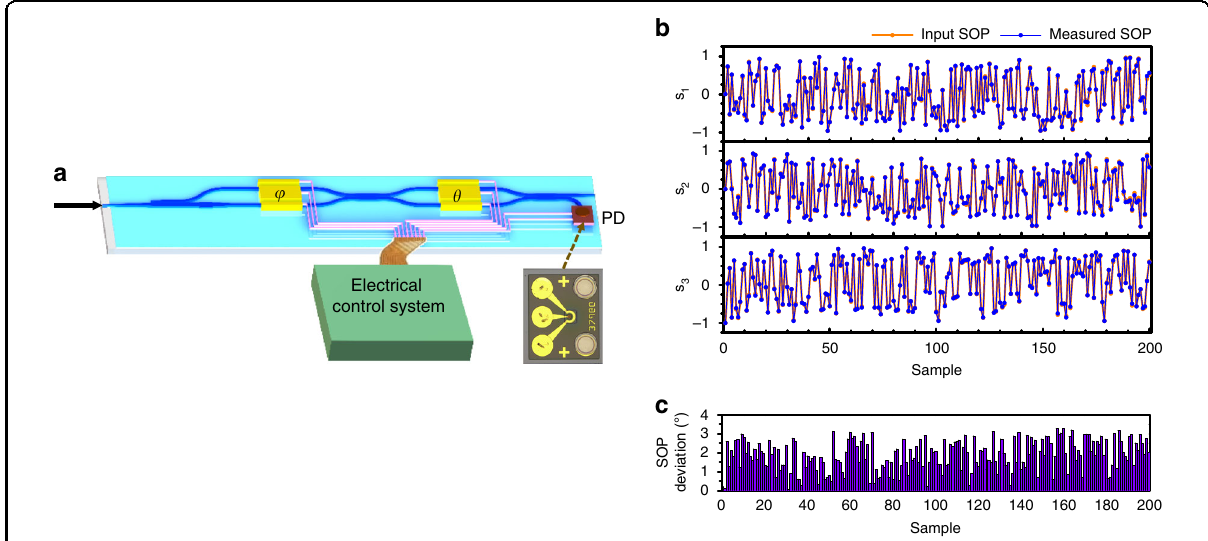
Fig. 4 Performance of the device for fast polarization measurement. a The experiment setup used for characterizing the fast polarization measuring device. Inset: the microscope image of a fl ip-chip bonded photodetector (PD). According to the optical intensities recorded by the PD, the input state of polarization (SOP) can be reconstructed. b The measured results (blue line) from the device and the corresponding input polarization states (orange line). c SOP deviation between the input SOP and the measured